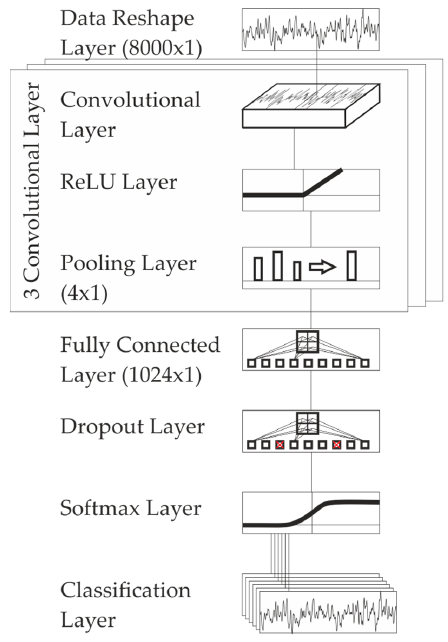
Figure 9. CNN architecture for classification.